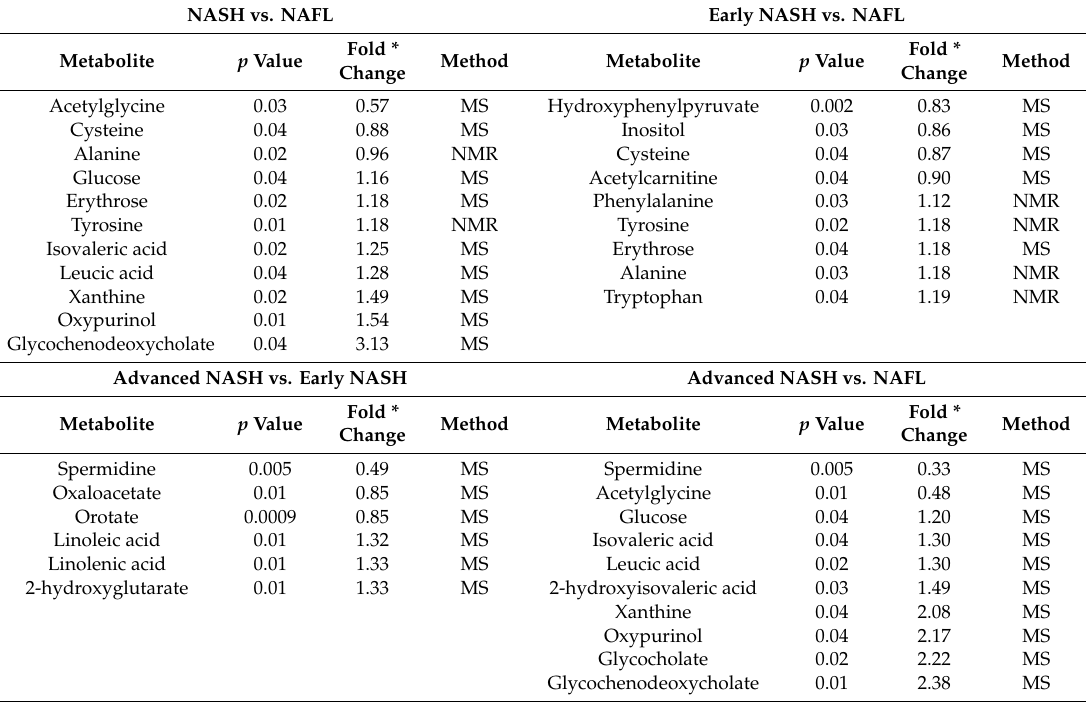
Table 2. Metabolites that di ff ered significantly between patients with NAFL ( n = 12), early NASH ( n = 31) and advanced NASH ( n =